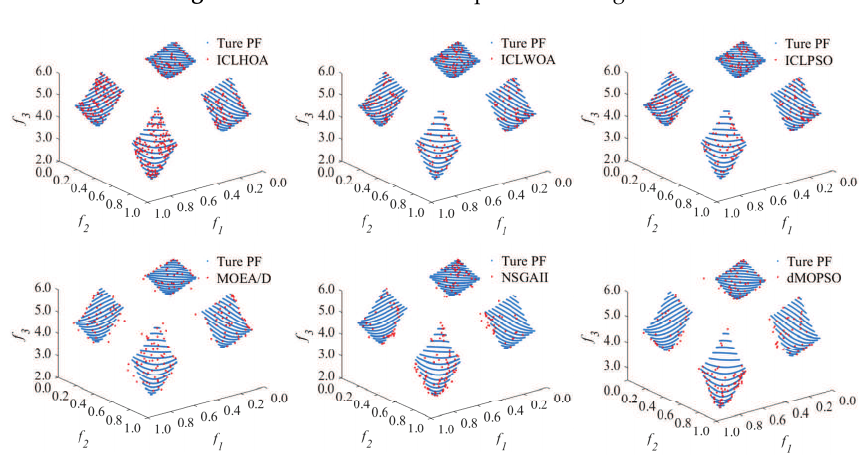
Figure 13. DTLZ2 PF of each optimization algorithm.